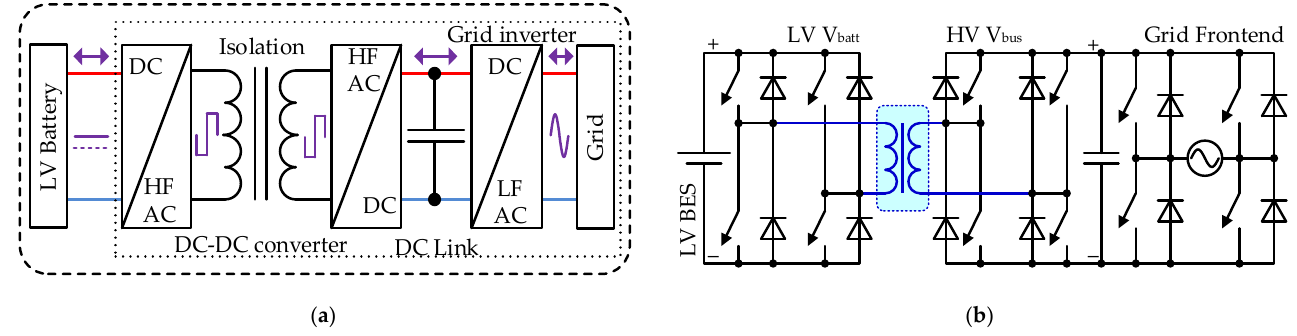
Figure 6. High-frequency transformers in the DC-link of the interface converter of LV BES: ( a ) functional diagram, ( b ) transformer in conjunction with classical DAB.